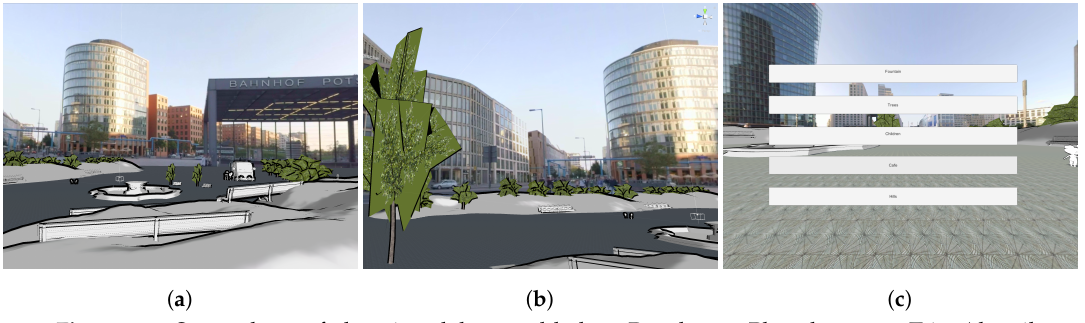
Figure 5. Screenshots of the virtual layer added to Potsdamer Platz by team Trio Akustiko. ( a , b ) Different perspectives on the virtual scene. ( c ) Buttons allow modification of the